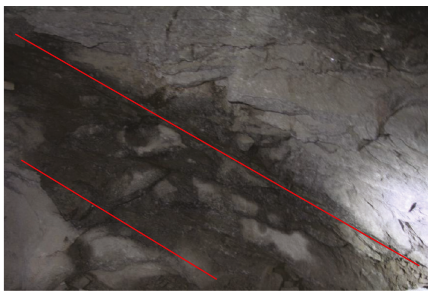
Figure 24: K0 +135 lamprophyre vein of the main powerhouse.